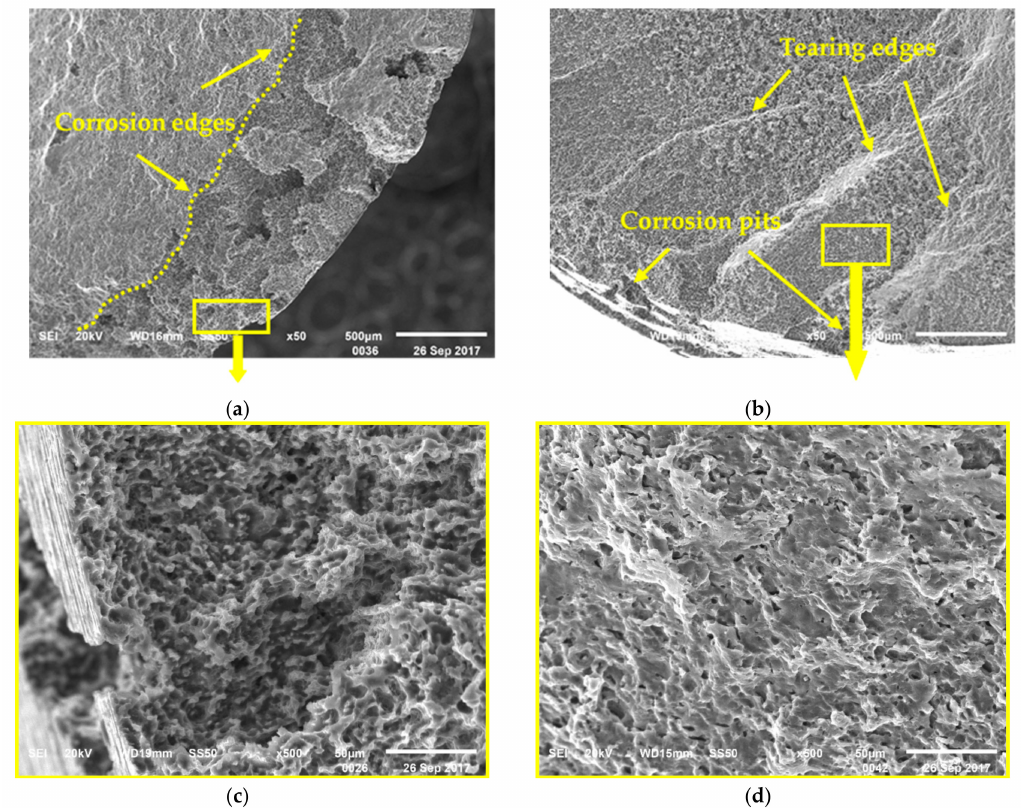
Figure 11. Fractographies of the SSRT test sample in 0.5 mol / L NaCl aqueous solution ( a ). ( b ) Overall, ( c ) Corrosion field, and ( d ) Field without corrosion.